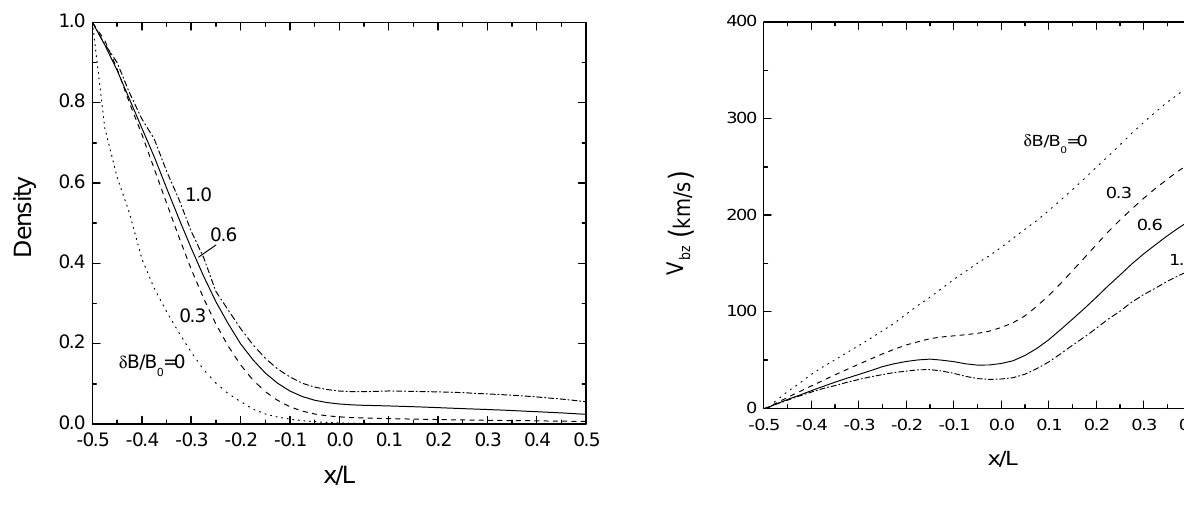
Fig. 8. Oxygen bulk velocity along z for different turbulence levels (as indicated).